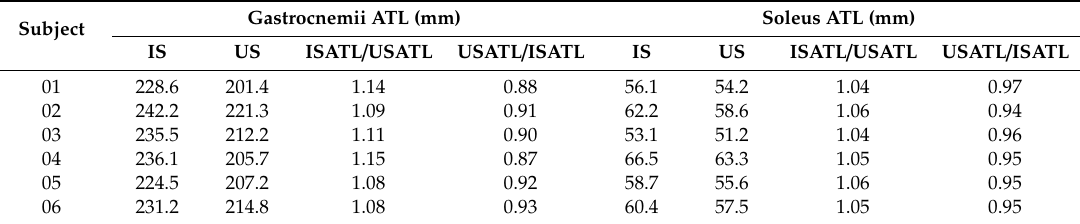
Table 1. Subject AT length details. The gastrocnemii and soleus AT lengths (ATL) of each subject were measured for both the involved and uninvolved